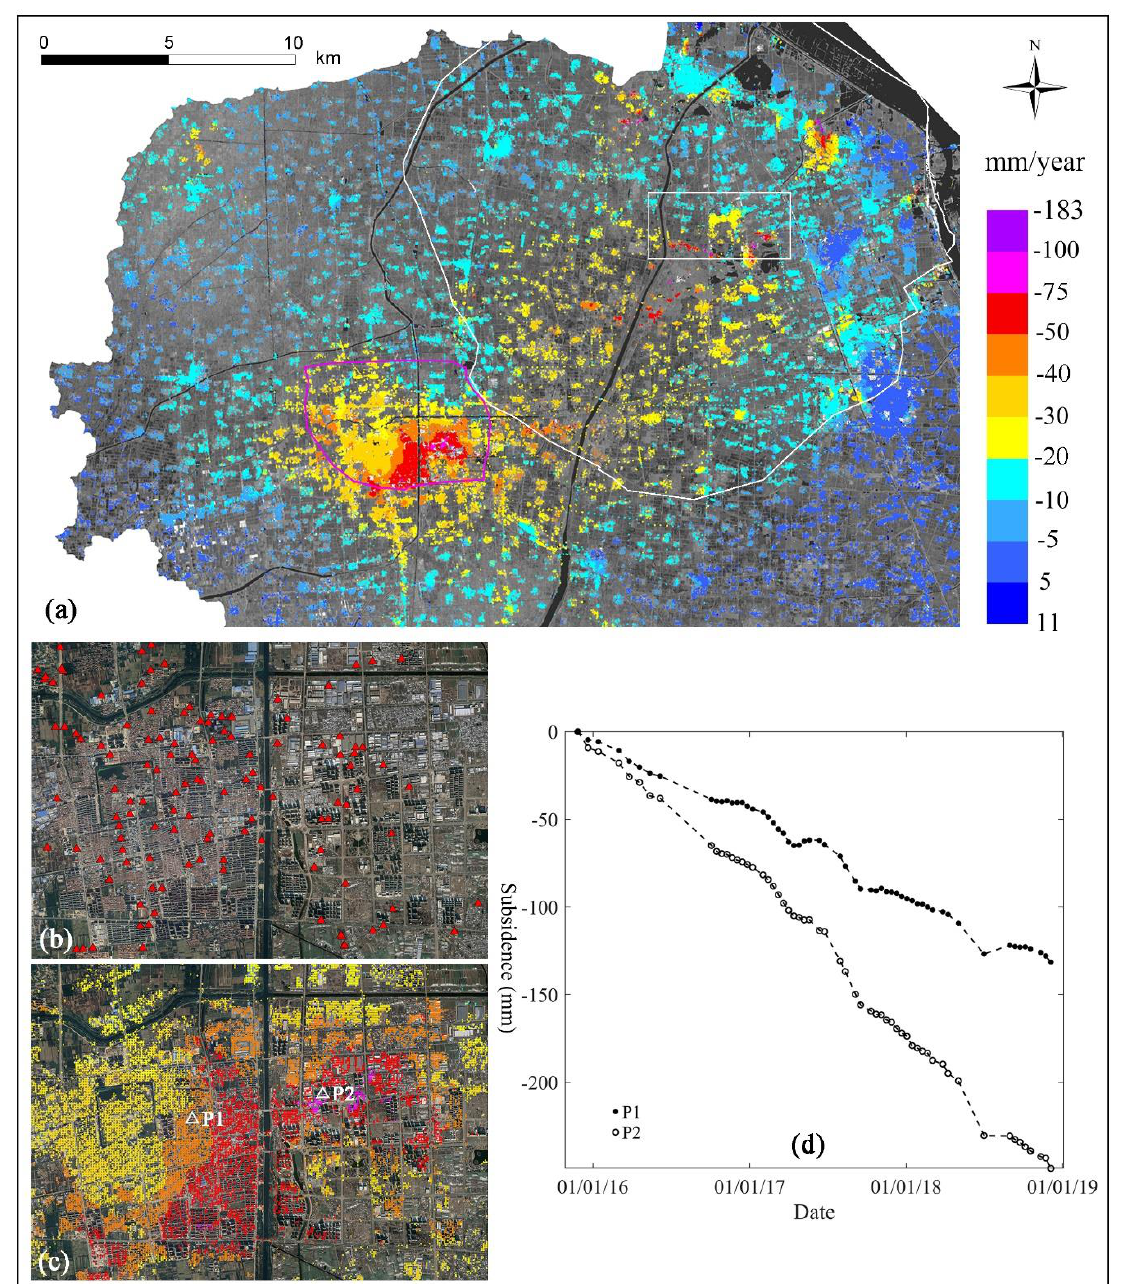
Figure 7. The enlarged view of MSV in Zone B of Figure 4 is shown in ( a ). The underground coal mining region is marked by the white-line polygon, and the urban area of Feng county is delineated by the purple-line polygon. Well locations within the Feng county are denoted by red-solid triangles overlaid on an optical image in ( b ), while MSV of CPs are overlaid in ( c ). The subsidence time series of two CPs denoted by white triangles in ( c ) is shown in ( d ). The area of interest (AOI) marked by the while-line rectangle in ( a ) is enlarged in Figure 8a.